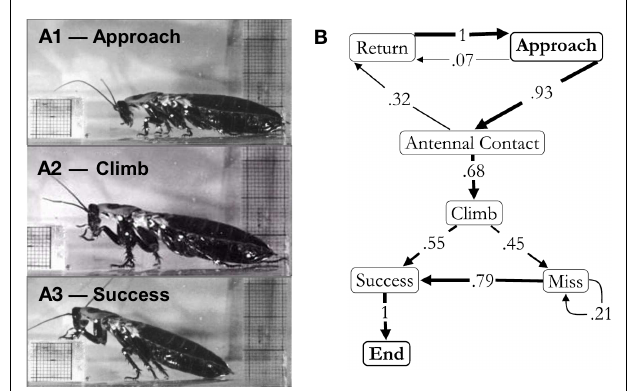
FIGURE 1 | (A) Block climbing behavior: approaching the block (1) , swinging the leg to climb (2) , and climbing success (3) . (B) Ethogram of block climbing in the light. Arrows represent a direct transition from one behavior to the next.The number on the arrow and its thickness represent the frequency of that transition.This was calculated by dividing the number of times a specific transition was made by the total number of transitions exiting a specific element. All behavioral sequences began with the cockroach approaching the block (approach). It could then turn around and walk away from the obstacle (return) before or after antennal contact (antennal contact).The cockroaches would then enter a climbing sequence (climb), which could either be successful, with their foot reaching the top of the obstacle (success), or not be successful (miss). In the event that the cockroach missed, it would then produce another climbing motion, which again could either be successful or not.The end of the behavioral sequence occurred when the cockroach climbed the block.The beginning and end of the sequence must be “approach” and “end,” respectively. For this reason these elements are represented in bold.This sequence represents the responses of 58 individuals (one trial per individual). From Harley et al.